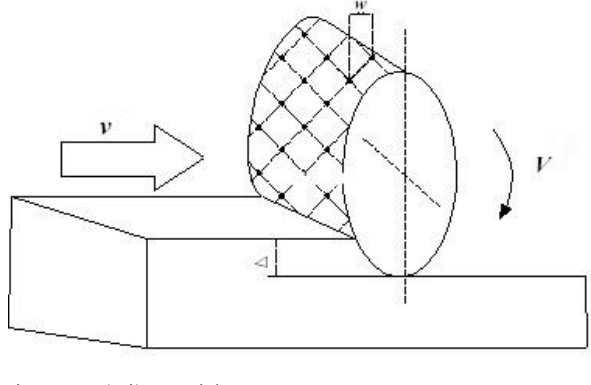
Figure 3: Grinding Model